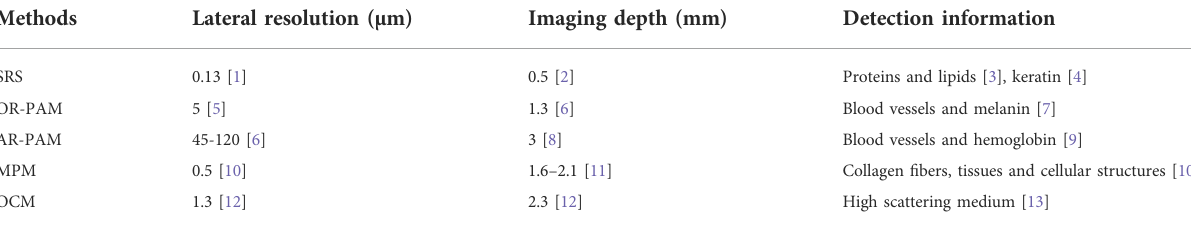
TABLE 1 Comparison of parameter information for SRS, OR-PAM, AR-PAM, MPM and